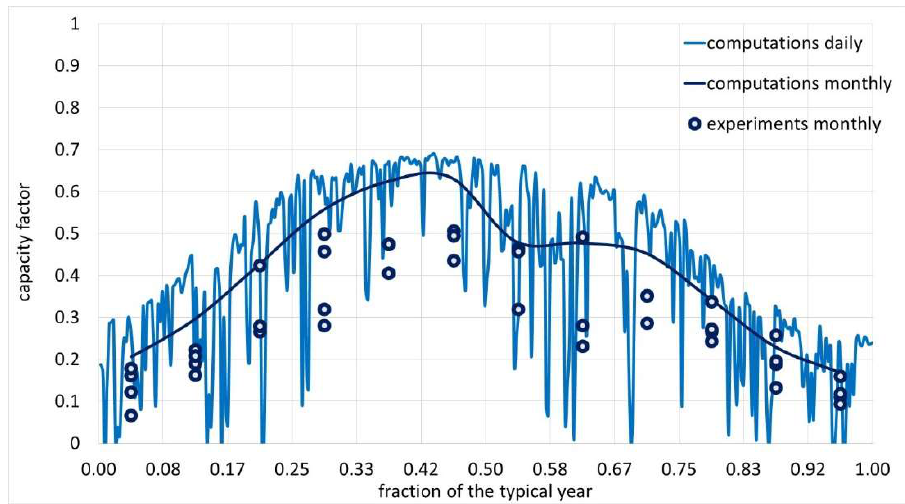
Figure 9. Solana solar facility. Daily and monthly capacity factors from computations and monthly capacity factors from experiments. X is the fraction of the year. Y is the capacity factor. The experiments are the values measured since the completion of the plant (multiple entries per month).